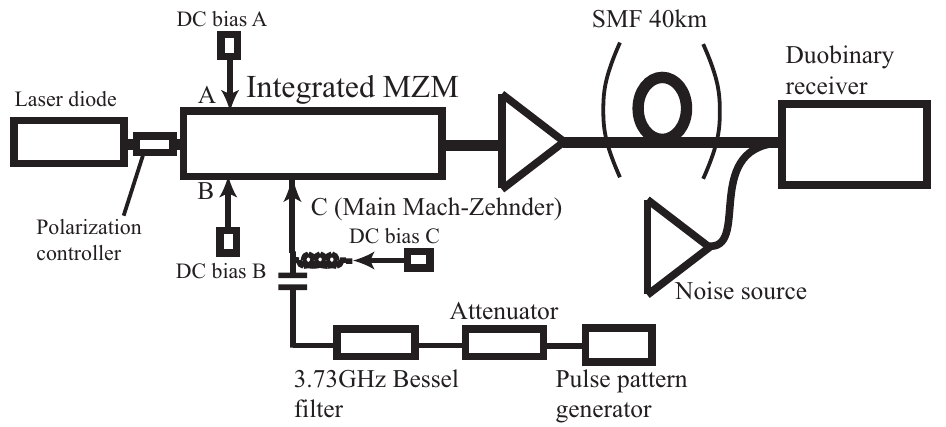
Figure 11. Experimental setup for duobinary transmission [12].